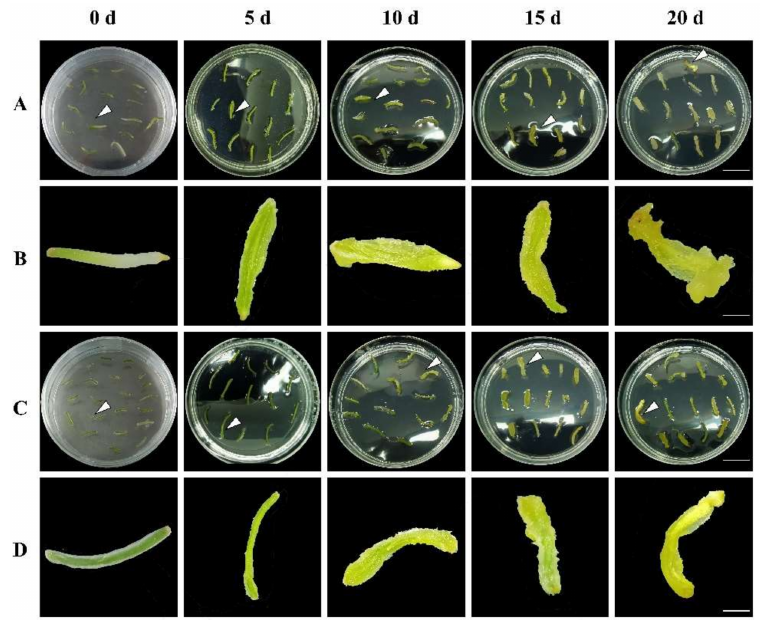
Figure 1. Morphological changes of the root tips and segments of A. praecox during callus induction. ( A ) Root tip. Bars = 1.0 cm; ( B ) Explants indicated by arrows in ( A ). Bars = 0.3 cm; ( C ) Root segments. Bars = 1.0 cm; ( D ) Explants indicated by arrows in ( C ). Bars = 0.3 cm.